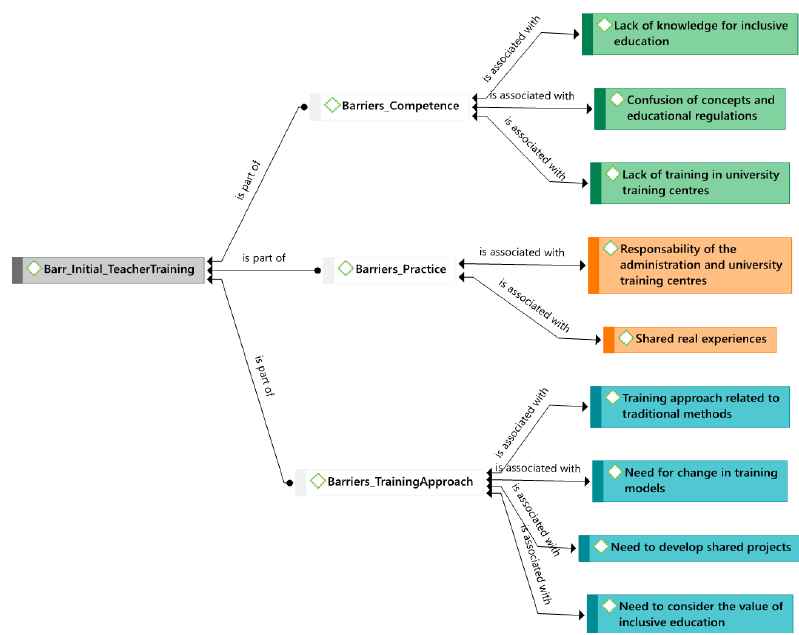
Figure 2. Codes for classification. Source: Prepared by the authors.